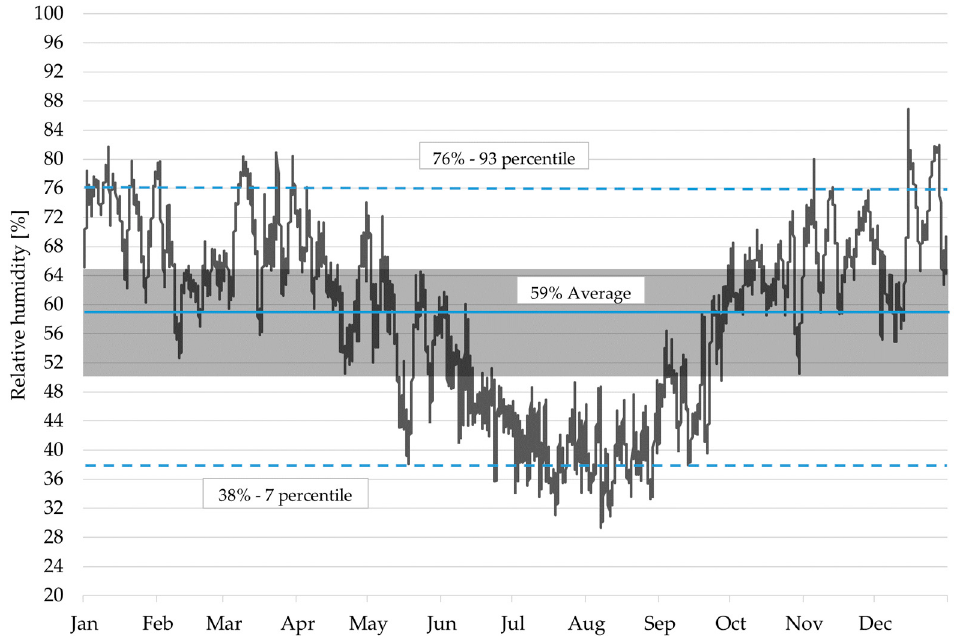
Figure 24. Trend of historic climate hourly values of RH and statistical limits of 93rd and seventh percentiles in room X vs. the range recommended by the Italian D.M. 10.05.2001 [16] (gray band).